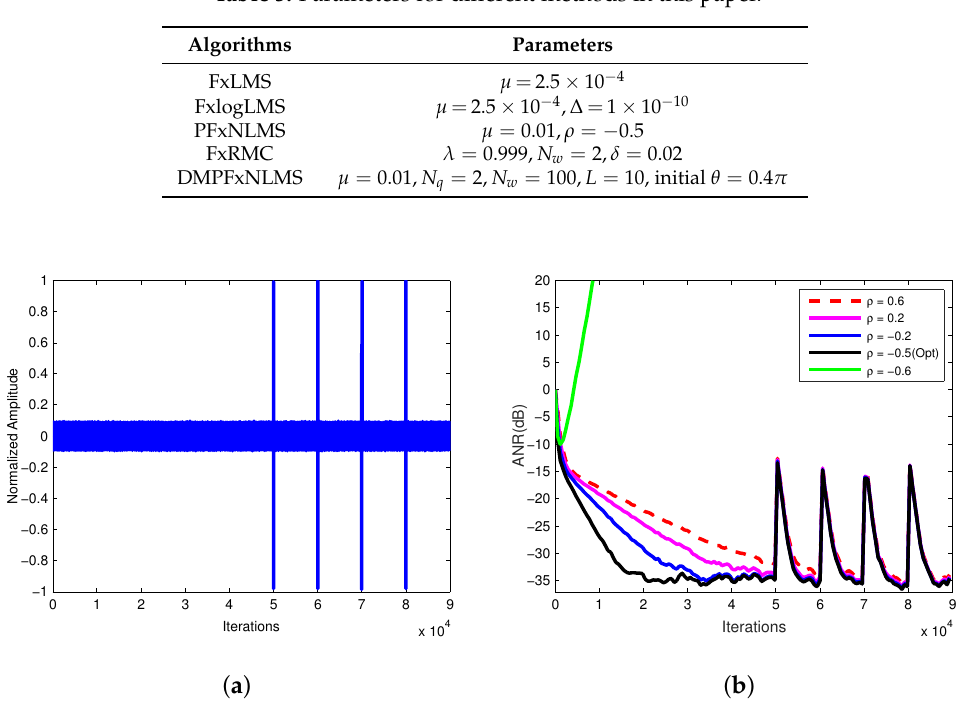
Figure 4. Selection of optimal ρ for PFxNLMS. ( a ) Reference signal in time domain; ( b ) ANR